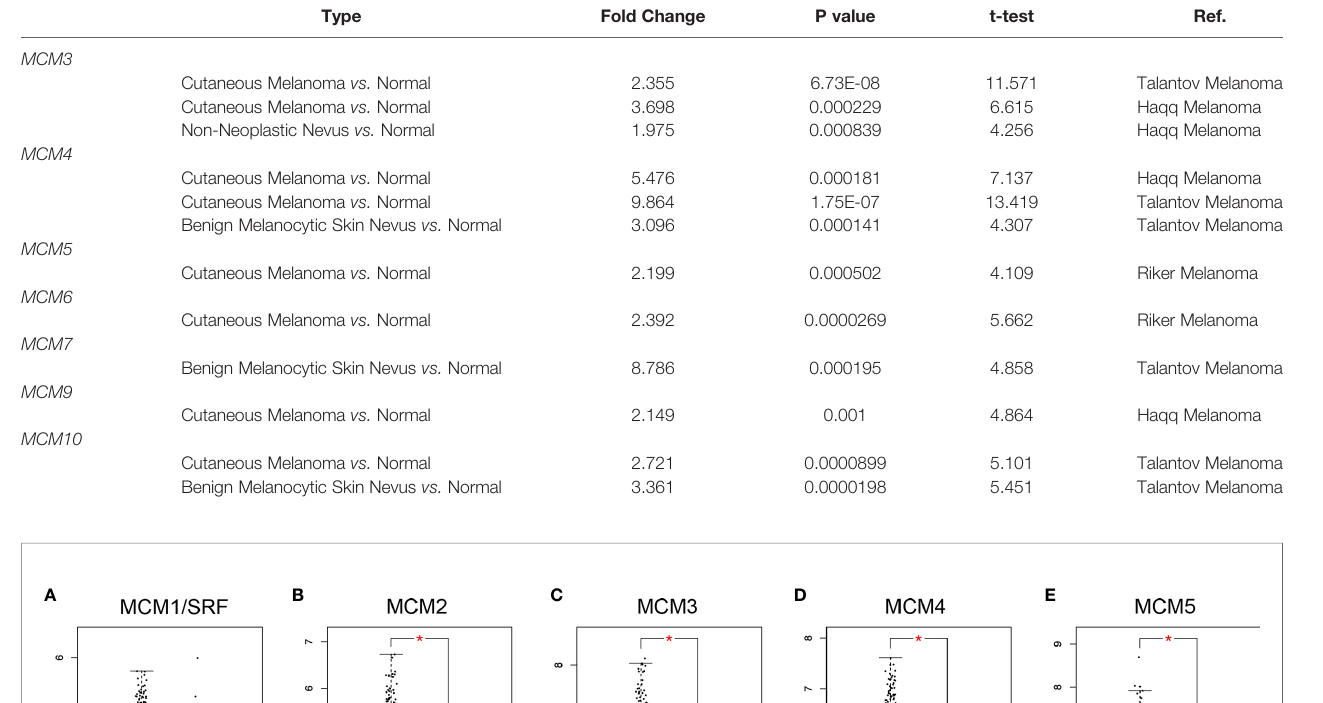
TABLE 1 | Comparison of mRNA expression of MCM s in melanoma and normal skin tissues from the Oncomine database. Type Fold Change P value t-test Ref.